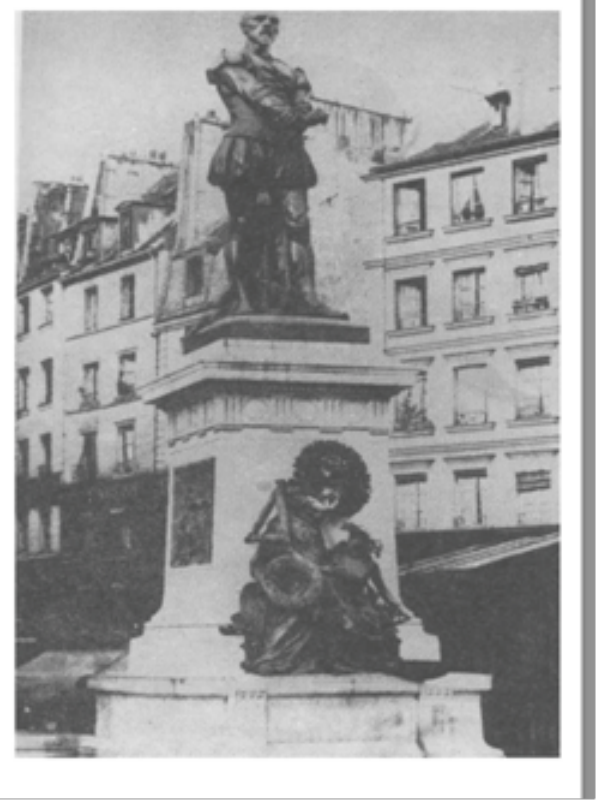
Figure 15. Anonymous. La Statue d’Etienne Dolet in Nadja Coll. Georges Sirot